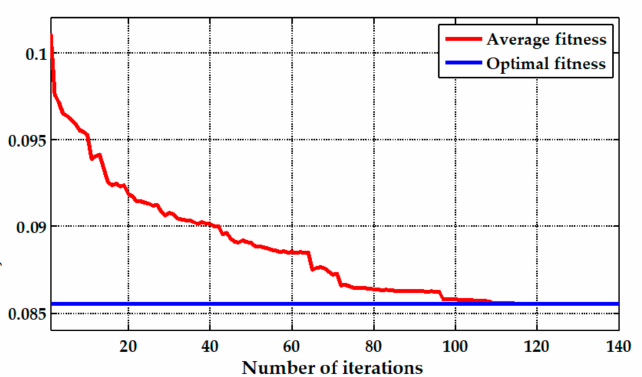
Figure 9. The convergence progress of the dual objective optimization for the coaxiality and unbalance based on